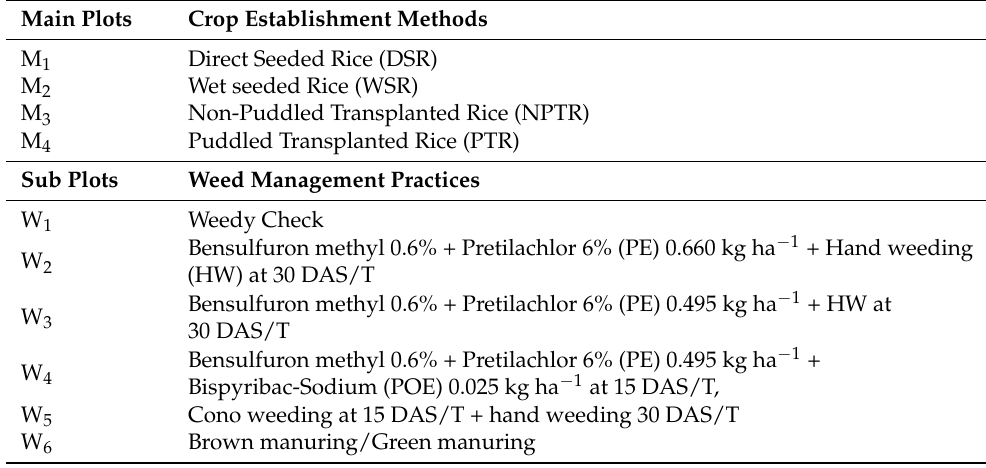
Table 4. Treatment details of the